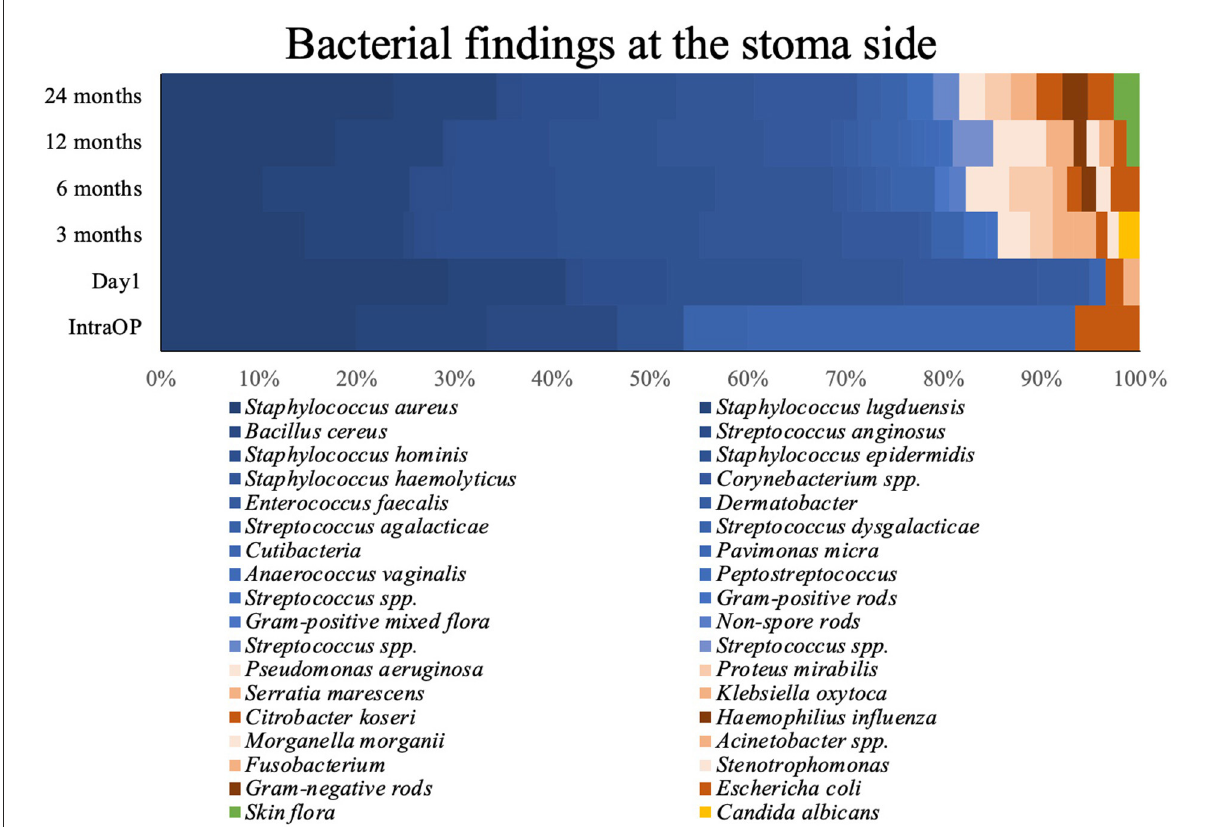
FIGURE2 Bacterial findings at the stomal side during the observed period. Blue, GPB; red, GNB; yellow, Candida albicans; green, Skin flora.